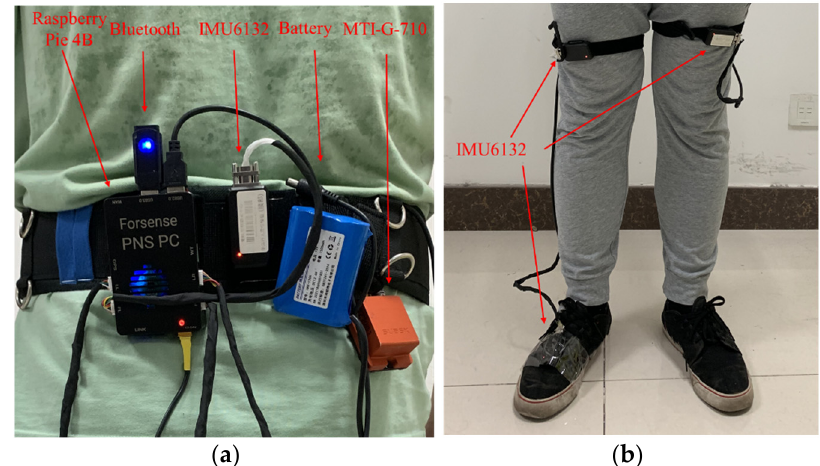
Figure 12. Schematic diagram of sensor installation. ( a ) Installation diagram of sensors on waist. ( b ) Installation diagram of sensors on leg and foot.